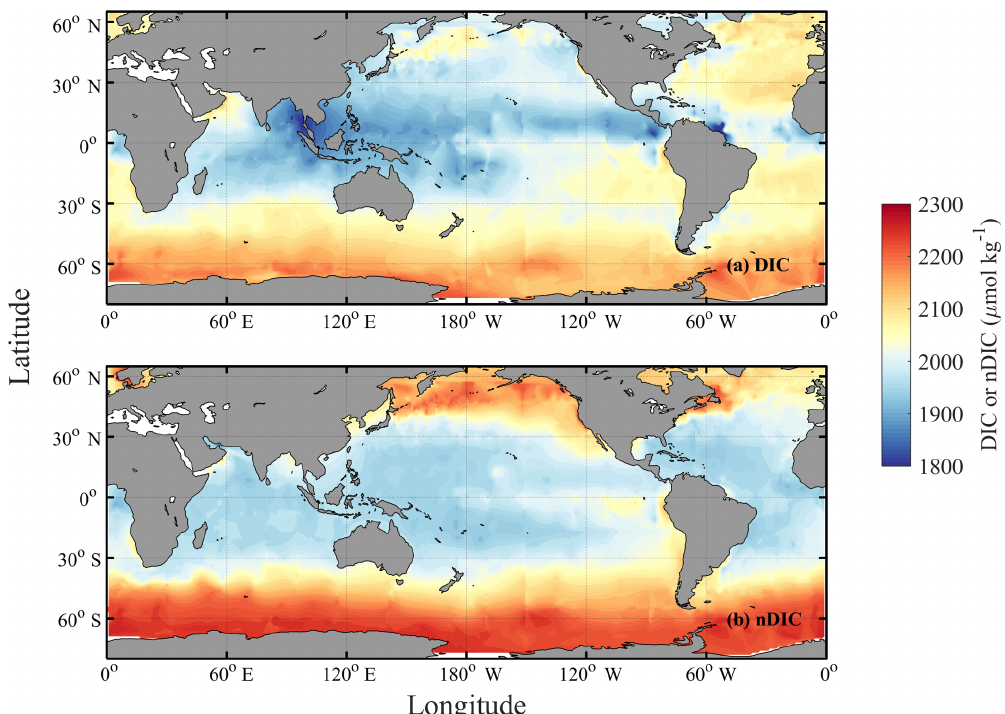
Figure 1. Spatial distributions of DIC and nDIC. (a) DIC (normalized to year 2005); (b) salinity-normalized DIC (nDIC, DIC normalized to reference year of 2005 and salinity of 35) in the surface global ocean. The latitudinal trends are clear, particularly for nDIC.